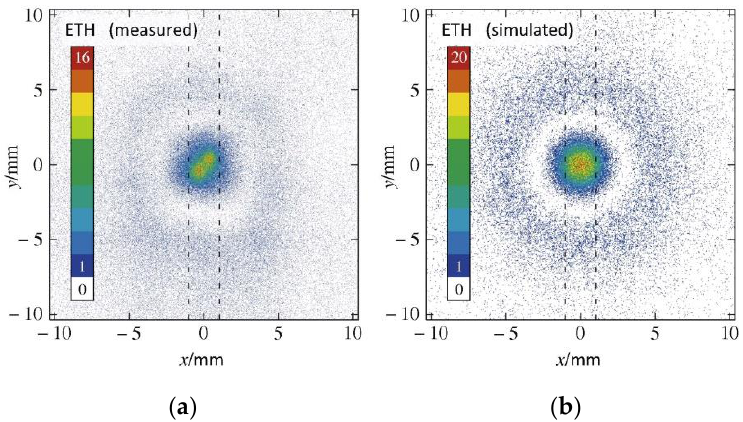
Figure 13. An Eidgenössische Technische Hochschule (ETH) capillary was used in an experiment with 71 MeV Xe 19+ : ( a ) measured profile and ( b ) simulated profile (figures reprinted from [34], Copyright (2014), with permission from Elsevier).